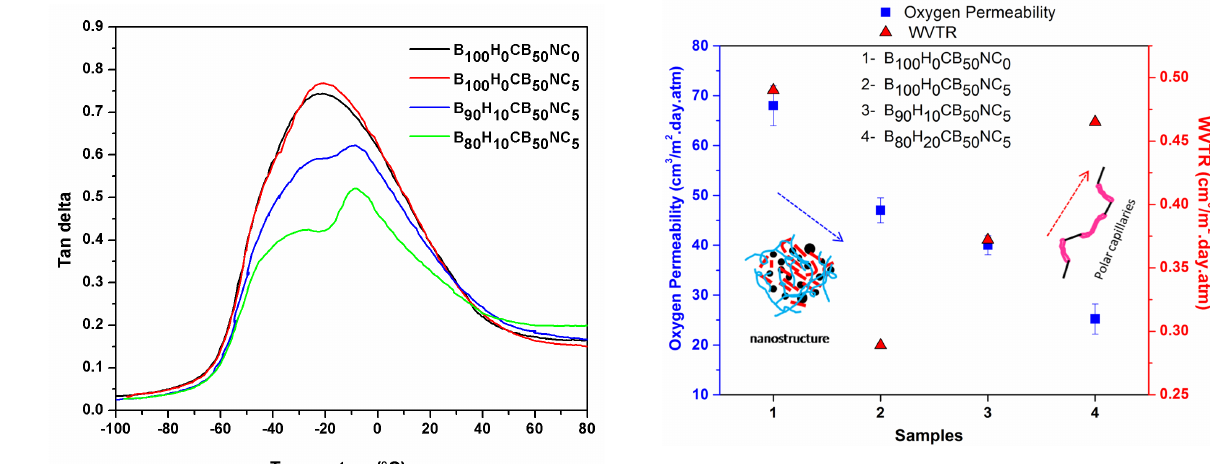
changes with the weight fraction of the polar rubber and tortuosity offered by clay platelets.